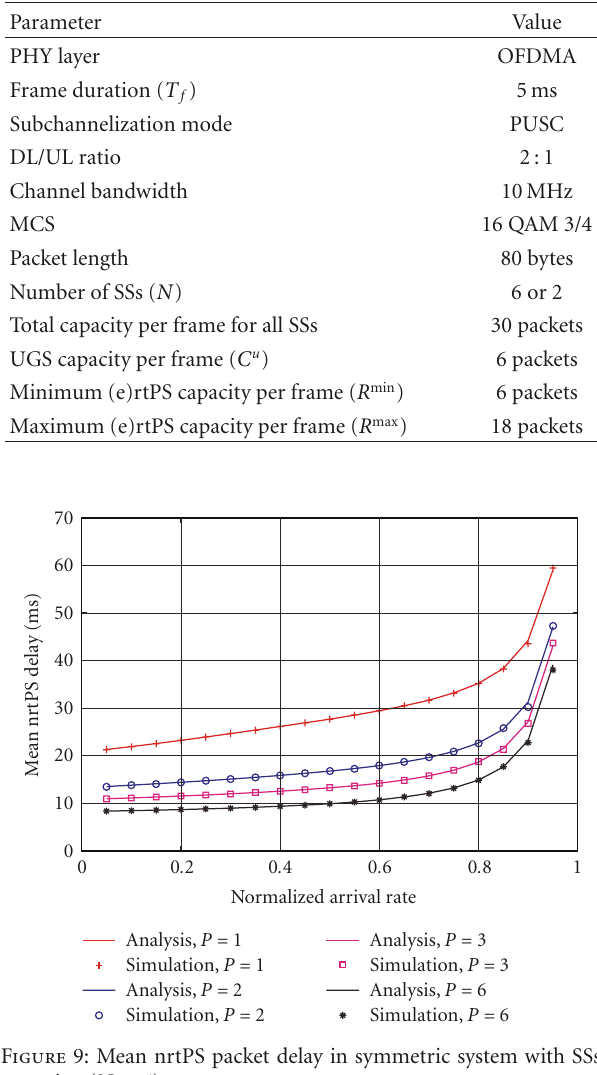
Figure 9: Mean nrtPS packet delay in symmetric system with SSs grouping ( N = 6).